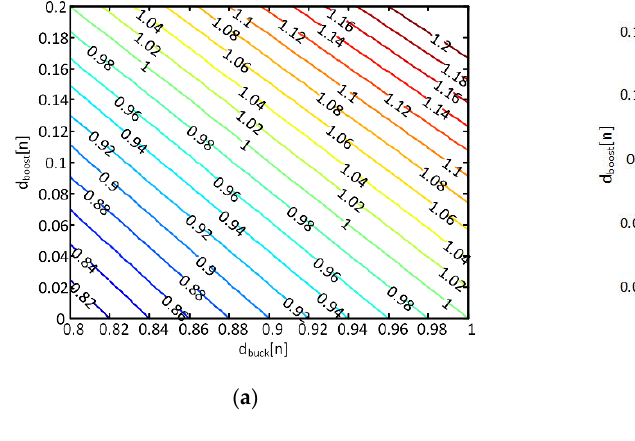
Figure 8. ( a ) Contour plots of constant M for different values of d buck [n] and d boost [n]. ( b ) Possible trajectories to find the appropriate (d buck [n],d boost [n]) pair as a function of d[n] in order to achieve a smooth transition. In this case d buck,max = 0.95, d boost,min =